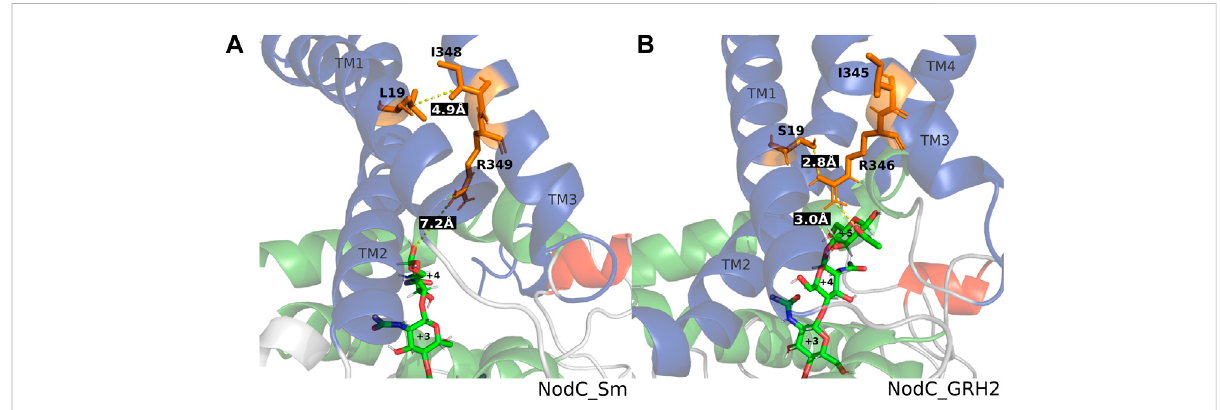
FIGURE 4 Distances within NodC_Sm (A) and NodC_GRH2 (B) . Shown are representative frames from molecular dynamics simulations. The wildtype proteinsaccommodateatetramer(left)orapentamer(right),thedistancesbetweentherelevantaminoacidsandtheCOSareindicatedinwhitefont on black. Color code: blue represents transmembrane, green cytoplasmic interfacing, red cytoplasmic helices, and the chitin oligomer is shown in stick representation with green carbon, blue nitrogen, and red oxygen atoms.